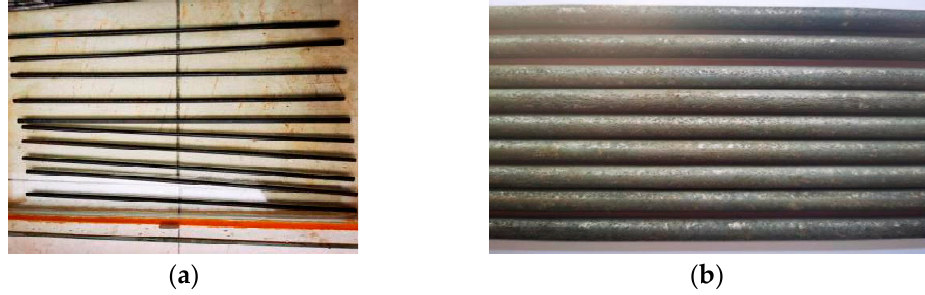
Figure 8. De-rusting of steel wire. ( a ) Derusting with hydrochloric acid, ( b ) De-rusting with steel wire.